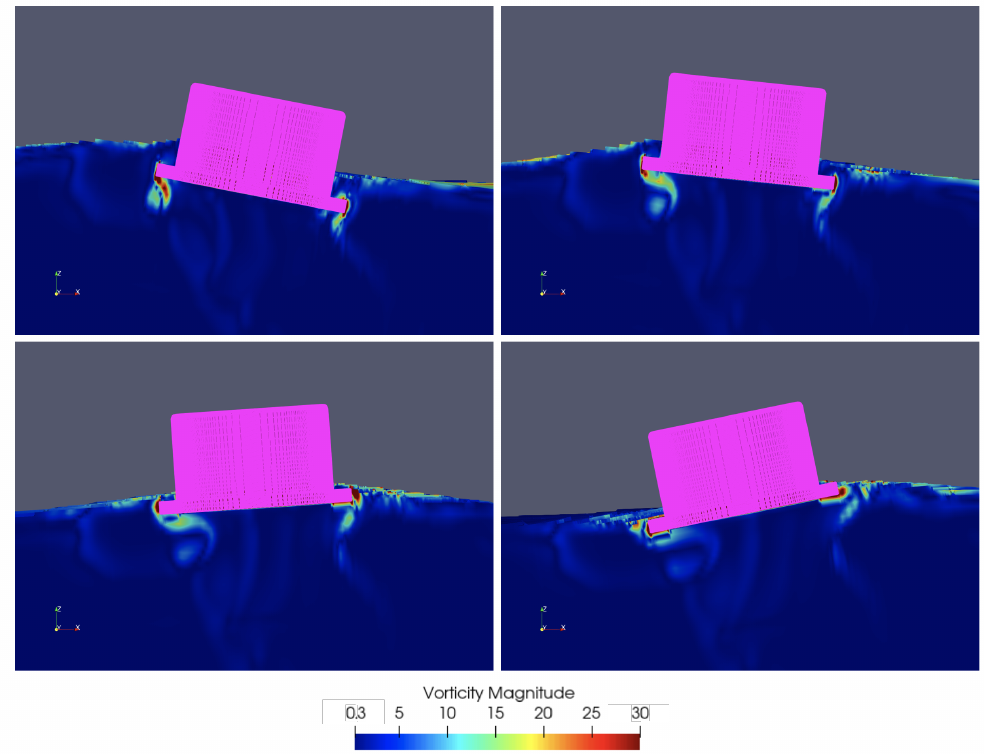
Figure 20. Snapshots of the magnitude of the vorticity near the skirt with H = 13.6 cm and T = 1.4 s from t/ T = 25.5 to